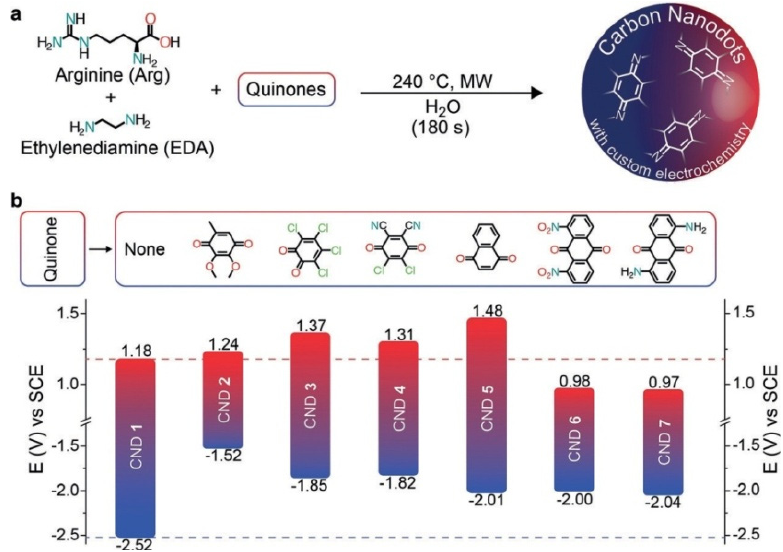
Figure 5. ( a ) Bottom-up synthesis of the CNDs. ( b ) Redox potentials of the CNDs (with the structures of the corresponding starting quinones employed as precursors). Reprinted with the permission of Reference [76]. Copyright 2018 Wiley-VCH Verlag GmbH & Co. KGaA, Weinheim.